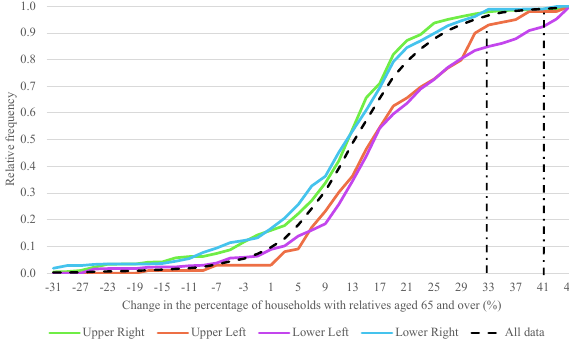
Figure 16 . Cumulative relative frequency of the changes in the percentage of households with relatives aged 65 and over between 2000 and 2015. The legend except “All data” is based on Table